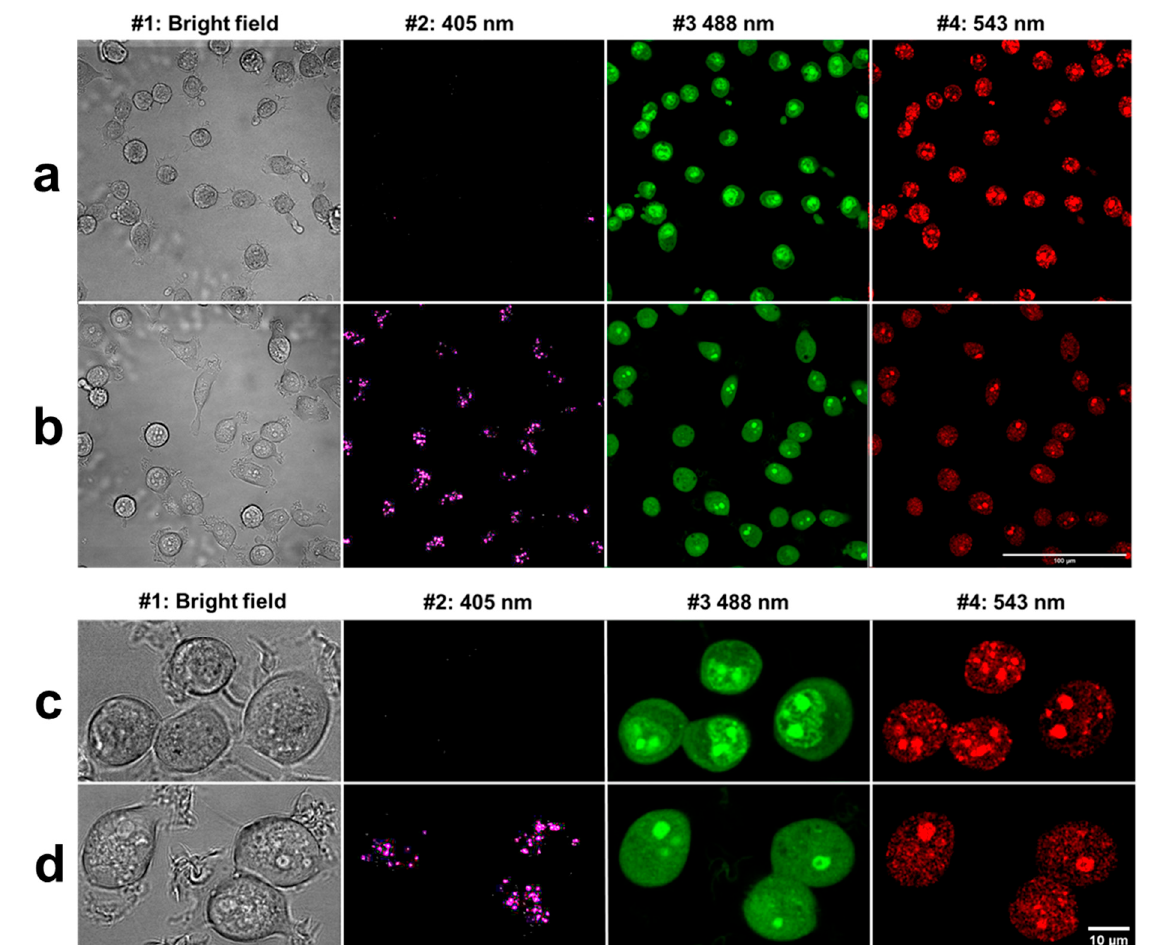
Figure 2. Confocal fluorescence microscopic images of HeLa cells labeled with AO or DM. Overview ( a , b ) and high-resolution images ( c , d ) of HeLa cells after AO ( a , c ) or DM ( b , d ) staining. Different excitation and emission settings were applied for the two dyes to optimize images for the intensity conditions of the captured image. From left to right: bright field of view illumination, 405, 488, and 543 nm laser light excitation for blue, green, and red emissions. One set of representative color images out of three similar experiments are displayed in this figure. The size marker corresponds to 100 µm for images ( a , b ) and 10 µm for images ( c , d ).